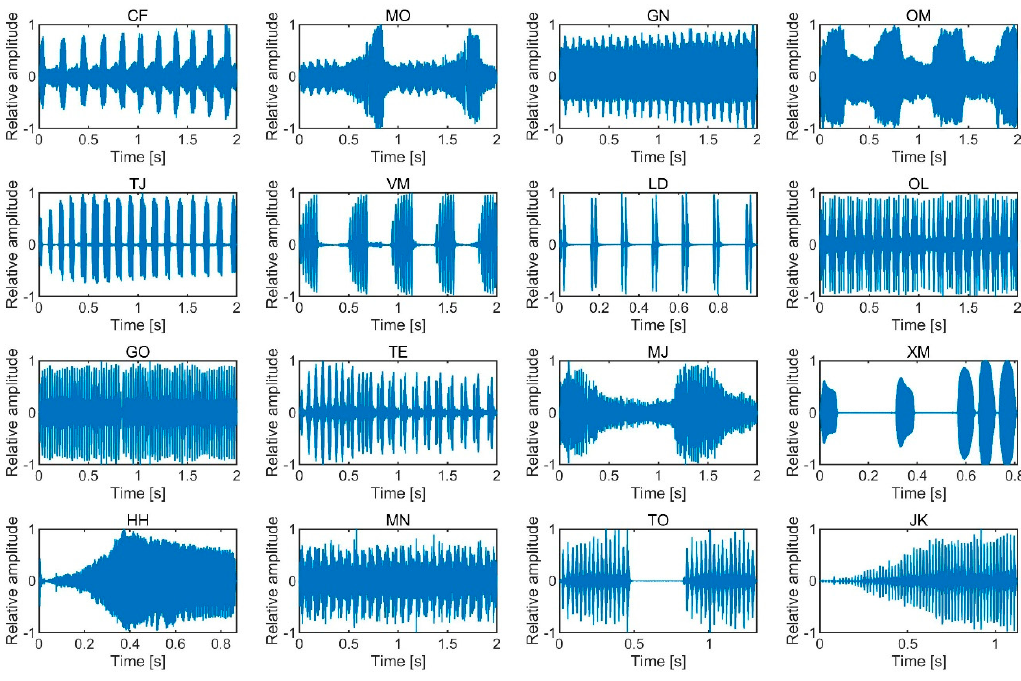
Figure 3. Temporal waveforms of the 16 insect song stimuli used.